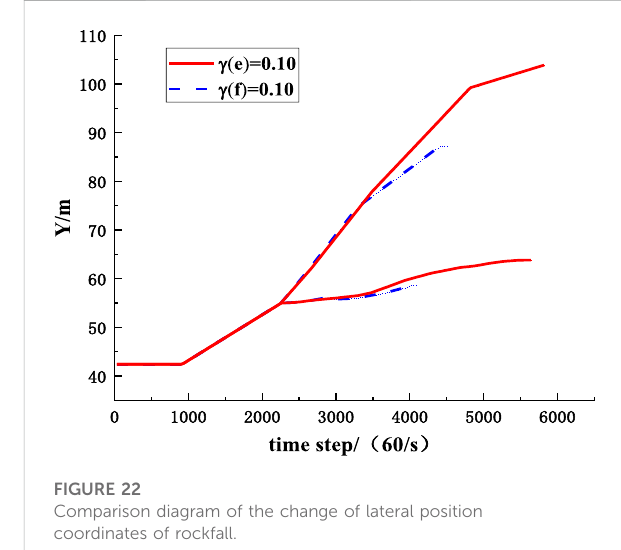
FIGURE 22 Comparison diagram of the change of lateral position coordinates of rockfall.